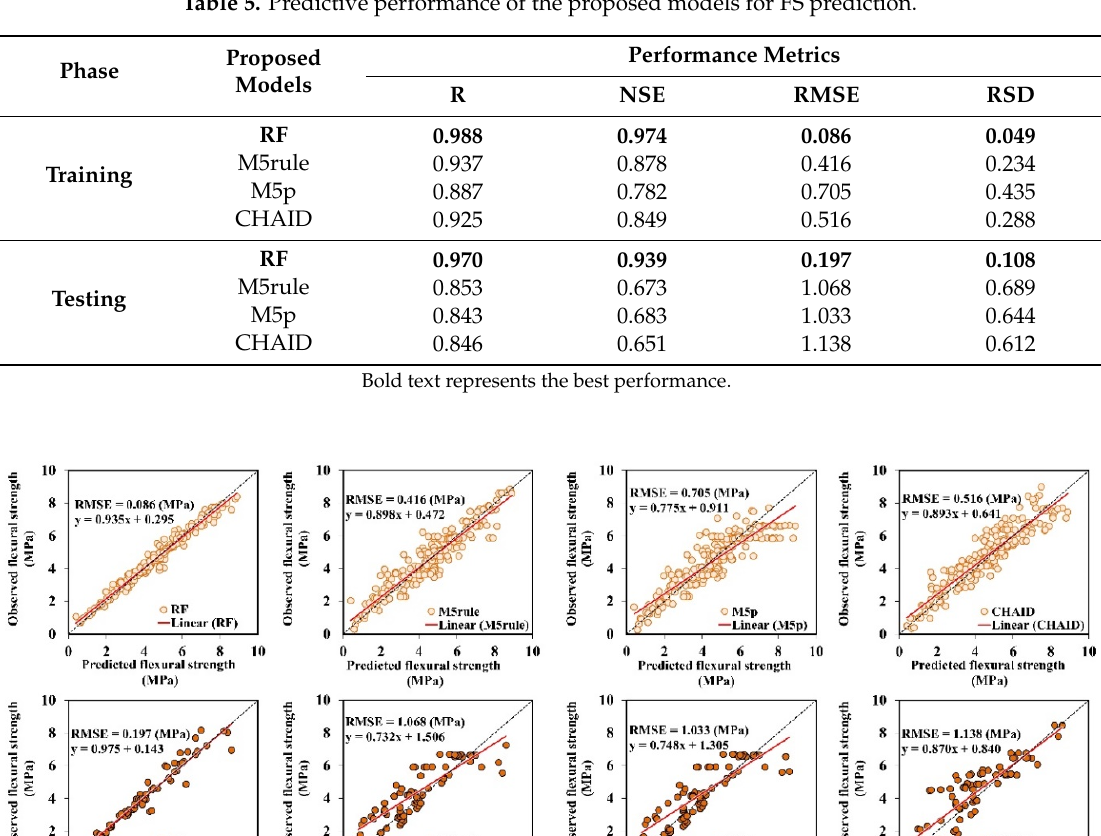
Table 5. Predictive performance of the proposed models for FS prediction.